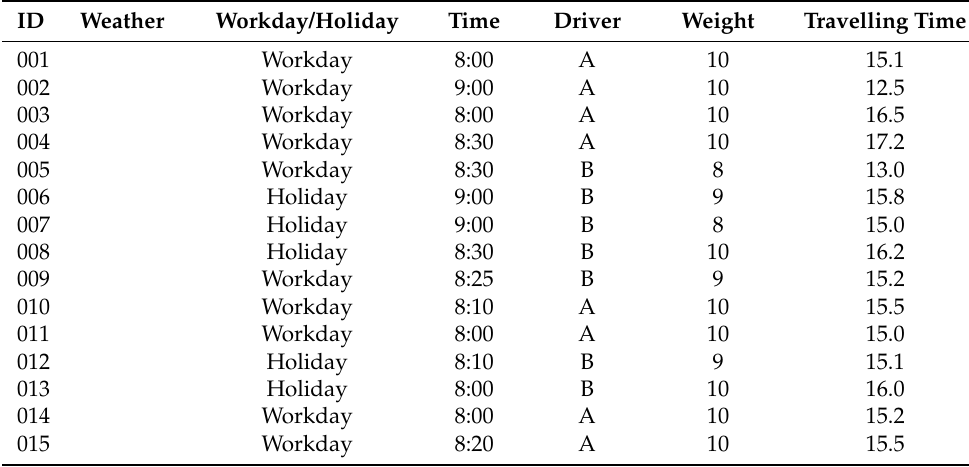
Table 2. CBR database of distribution center and second